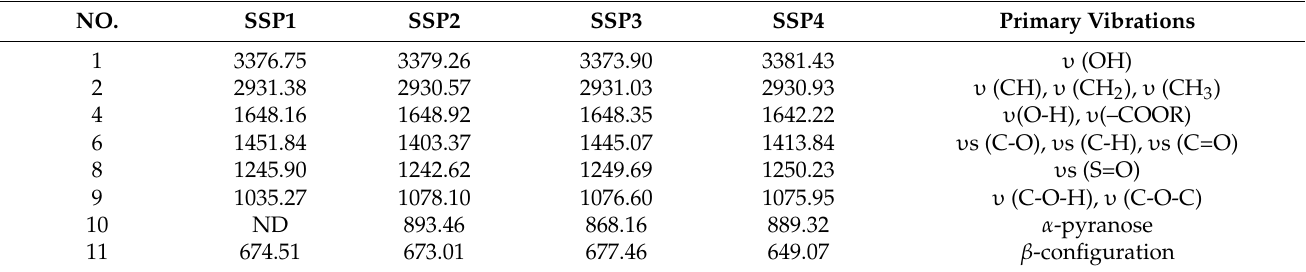
Figure 3. The FT-IR spectrum of SSPs. Table 4. The FT-IR absorption of SSPs.